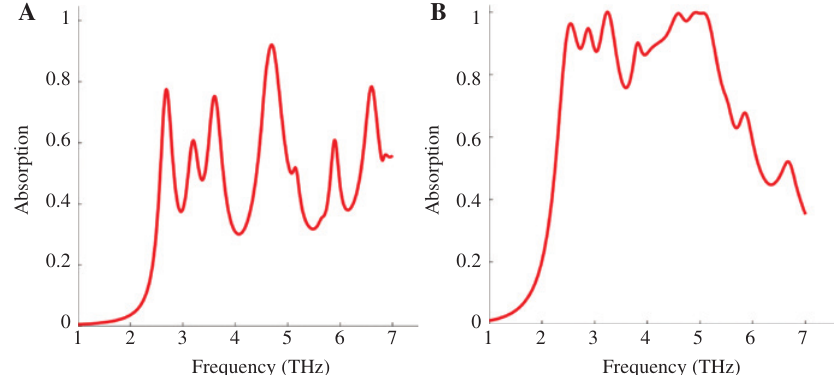
Figure 6: Absorption spectrum of broadband supercell design. (A) Polyimide thickness h = 6 μ m, (B) polyimide thickness h = 11 μ